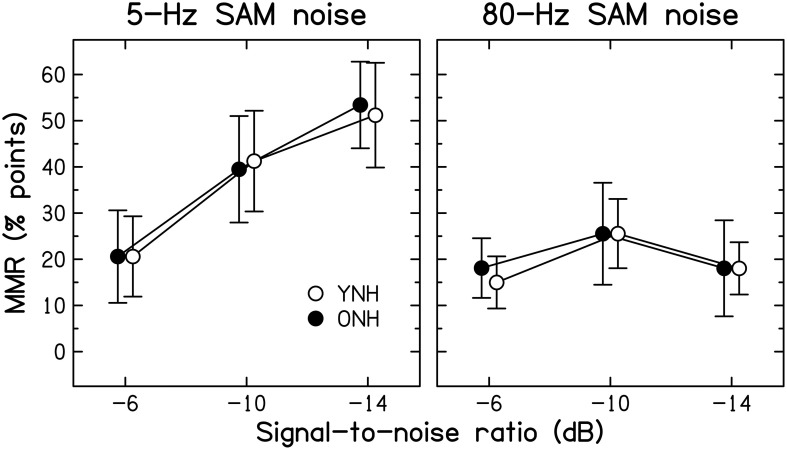
Average amount of modulation masking release (MMR, in percentage points) for YNH (open symbols) and ONH (filled symbols) participants. MMR is the difference in scores obtained using an SAM noise [SAM frequency = 5 Hz (left panel) or 80 Hz (right panel)] and an unmodulated noise.